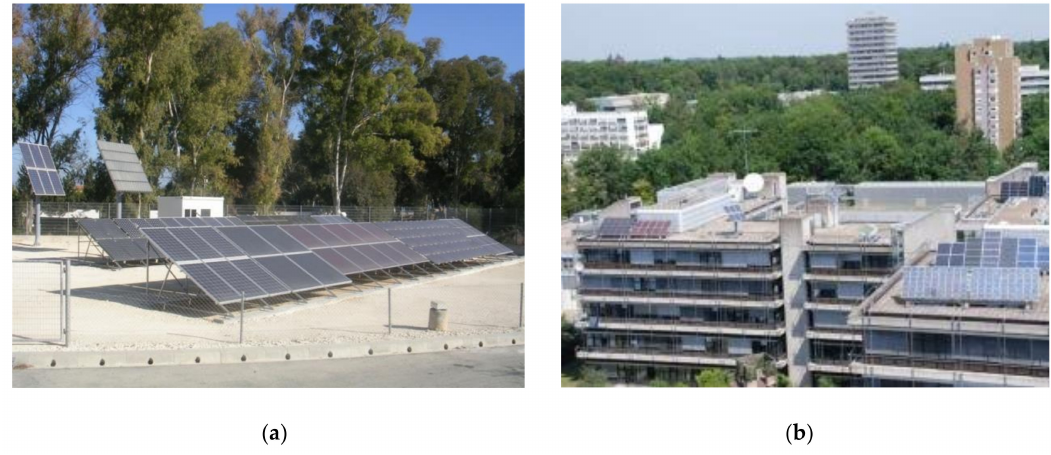
Figure 1. Outdoor photovoltaic (PV) system test facilities at the: ( a ) FOSS research centre in Nicosia, Cyprus; ( b ) Institute for Photovoltaics in Stuttgart, Germany.